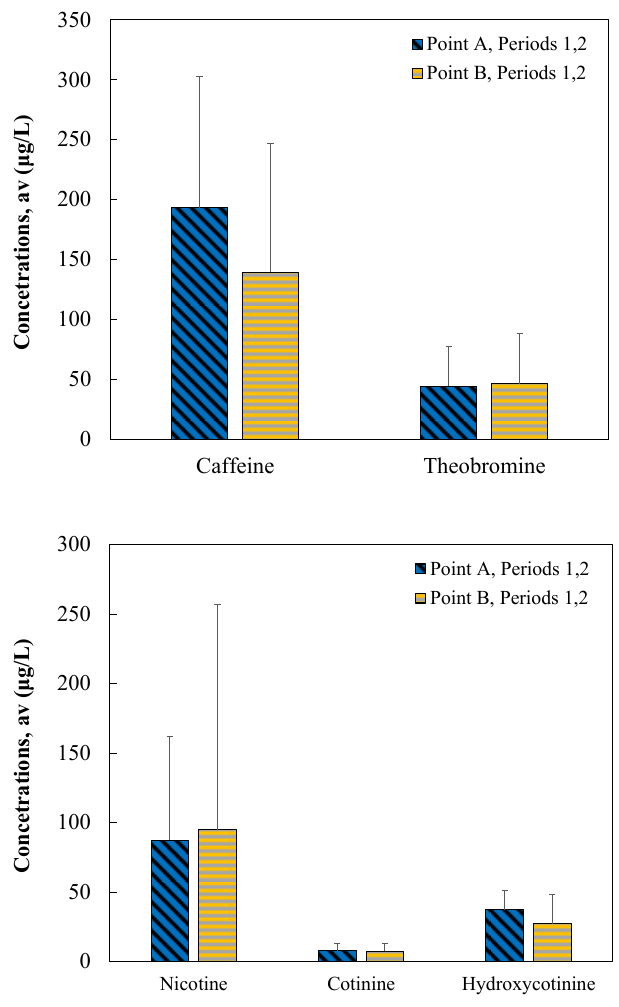
Figure 5. Average concentrations of the parent compounds and their associated transformation products in HWW samples of each sampling site (results as mean ± sd).